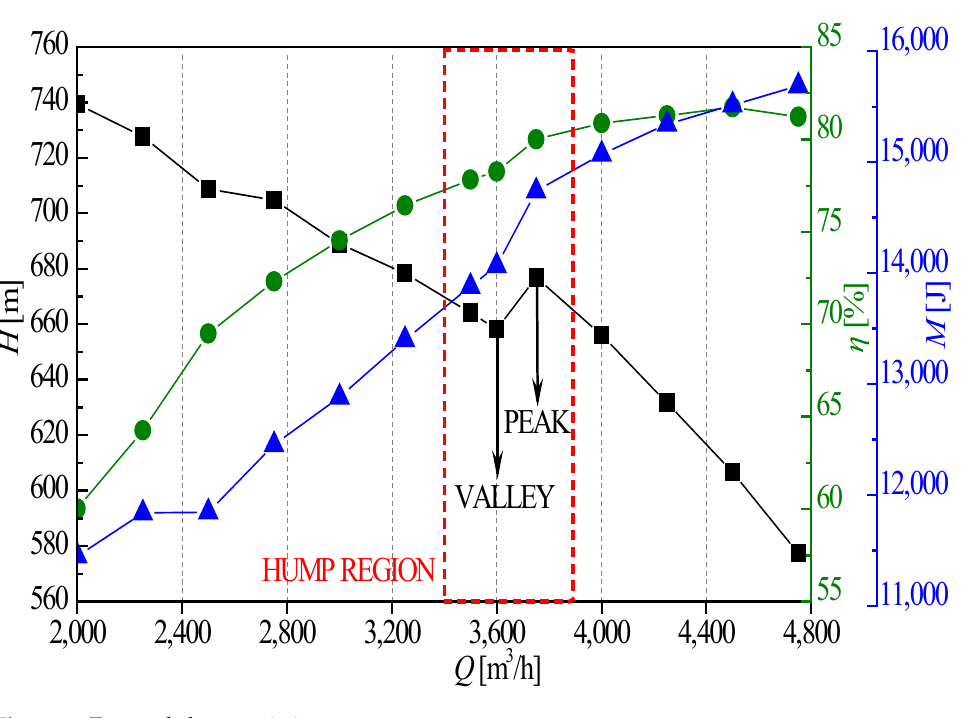
Figure 3. Calculation feasibility verification.